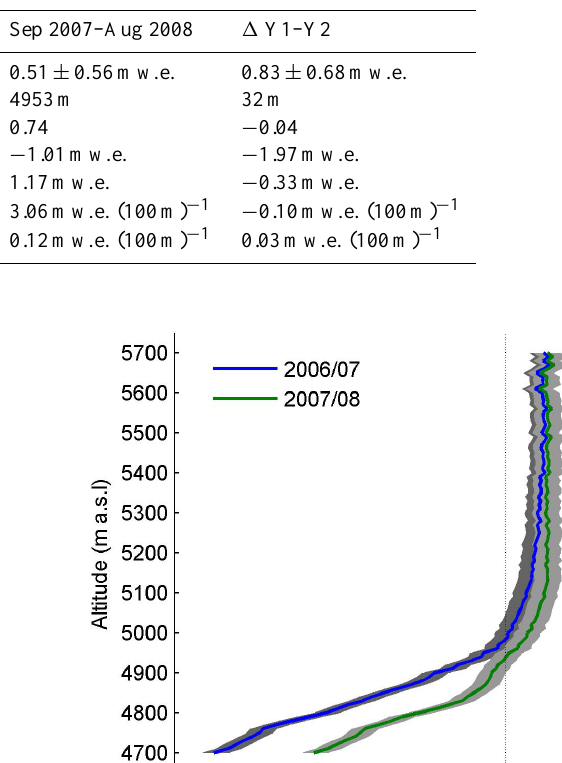
Table 1. Summary of glacier mass balance characteristics for the two hydrological years and difference between year 1 and year 2. The annual model uncertainties are calculated with Eq. (5) (yearly values) and Eq. (6) ( 1 Y1–Y2) as described in Sect. 2.2.3. ELA means equilibrium line altitude, AAR is the accumulation area ratio and MB is the mass balance.